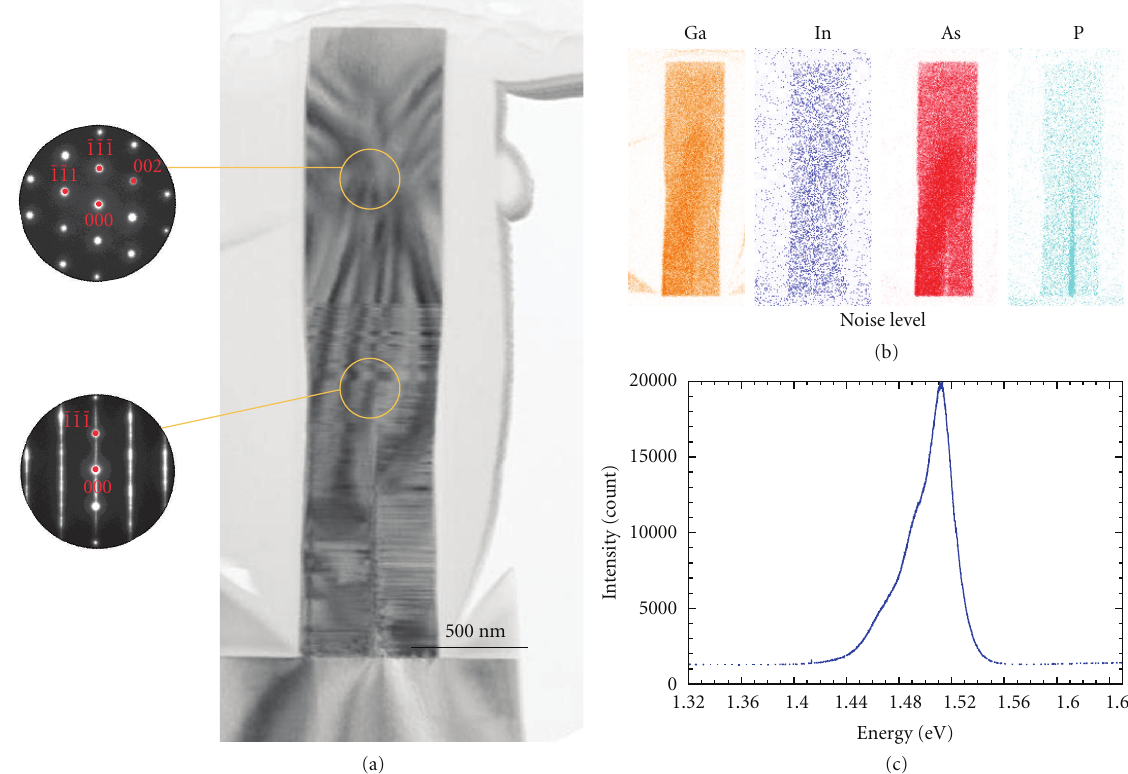
Figure 6: GaAs nanopillar containing an InAs dot. (a) HR-TEM image of the nanopillar and SAED patterns; (b) element mapping by EDS obtained from K lines; (c) PL spectrum of one nanopillar at 4K.